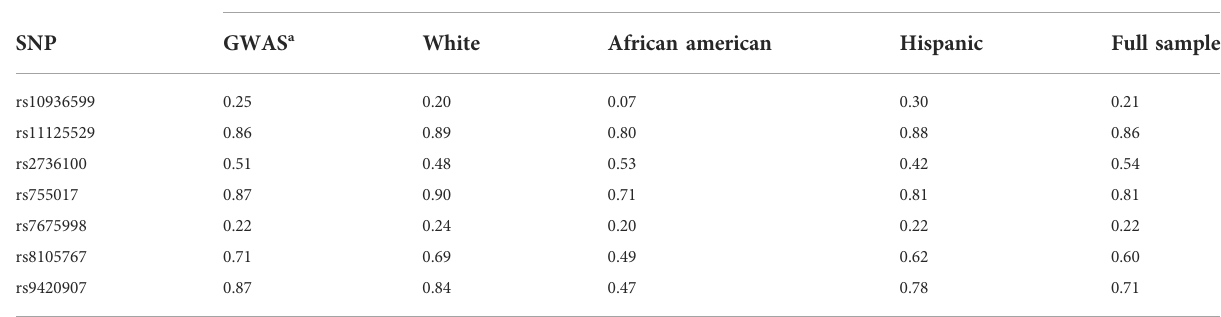
TABLE 2 Effect Allele Frequencies SNPs included in the